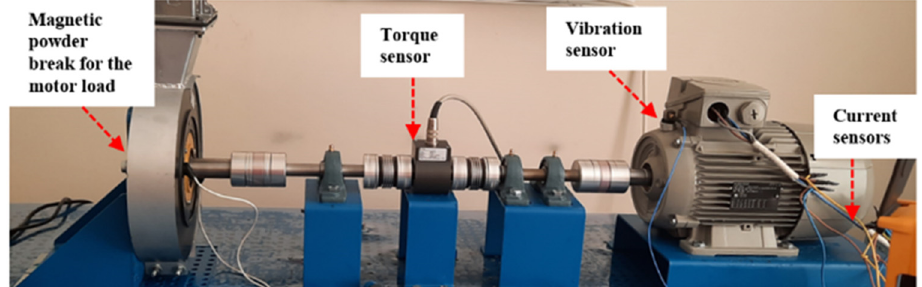
Figure 1. An overview of the implemented CPS architecture for PdM applications.